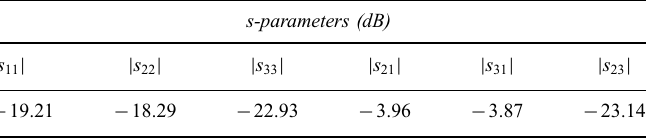
TABLE III Exact Values of All s -parameters of the Final 90-deg Coupler Design at the Desired Frequency. s-parameters